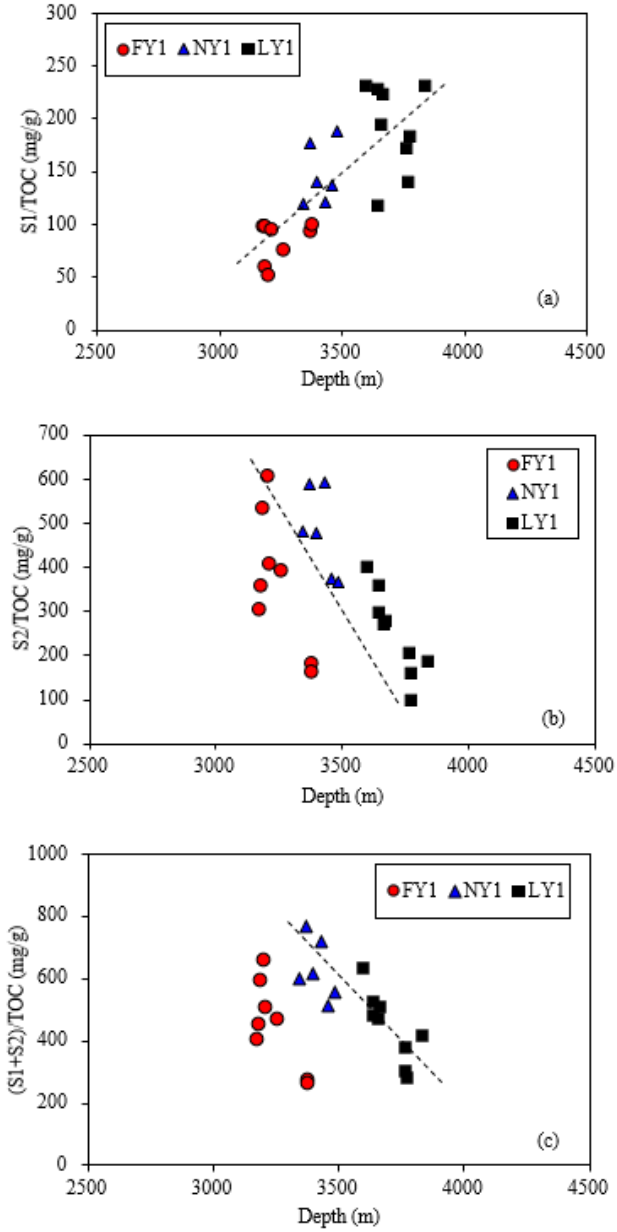
Figure 3. Relationships of burial depths with S1/TOC ( a ), S2/TOC ( b ), and (S1 + S2)/TOC ( c ) for the studied samples.